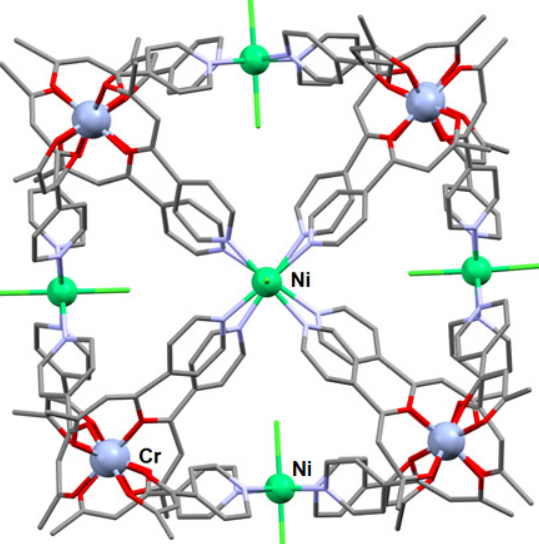
Figure 4. Crystal structure of [Cr III8 Ni II6 L 24 Cl 12 ], where LH = 1-(4-pyridyl)butane-1,3-dione. The